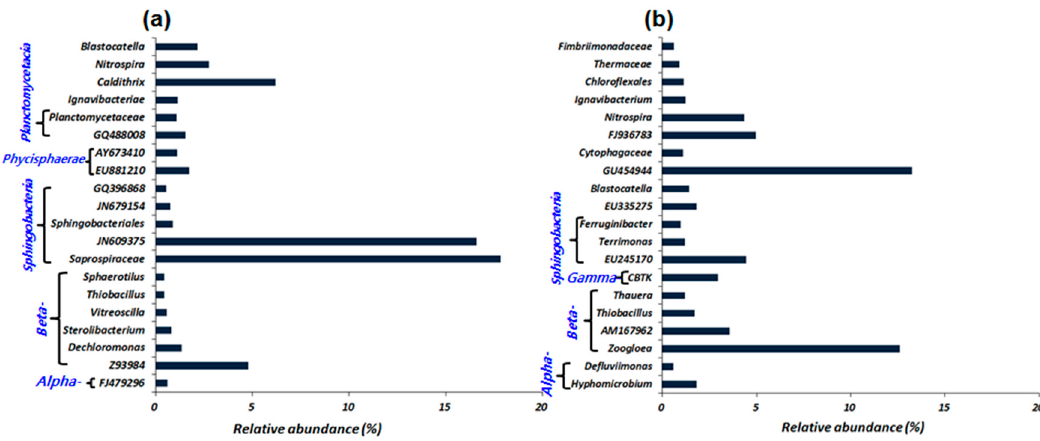
Figure 6. Top twenty genus levels of taxonomic classification with relative abundance: ( a ) Mixed liquor from the DWW; and ( b ) mixed liquor from the HWW.